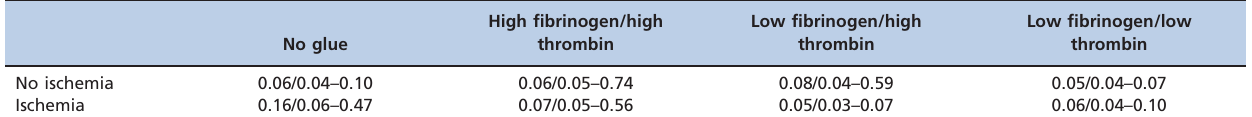
Table 2 - Colon hydroxyproline content in rats from all experimental groups. No significant differences were detected between or among groups (Kruskal–Wallis one-way ANOVA on ranks). The data are presented as the median/25–75% confidence interval.